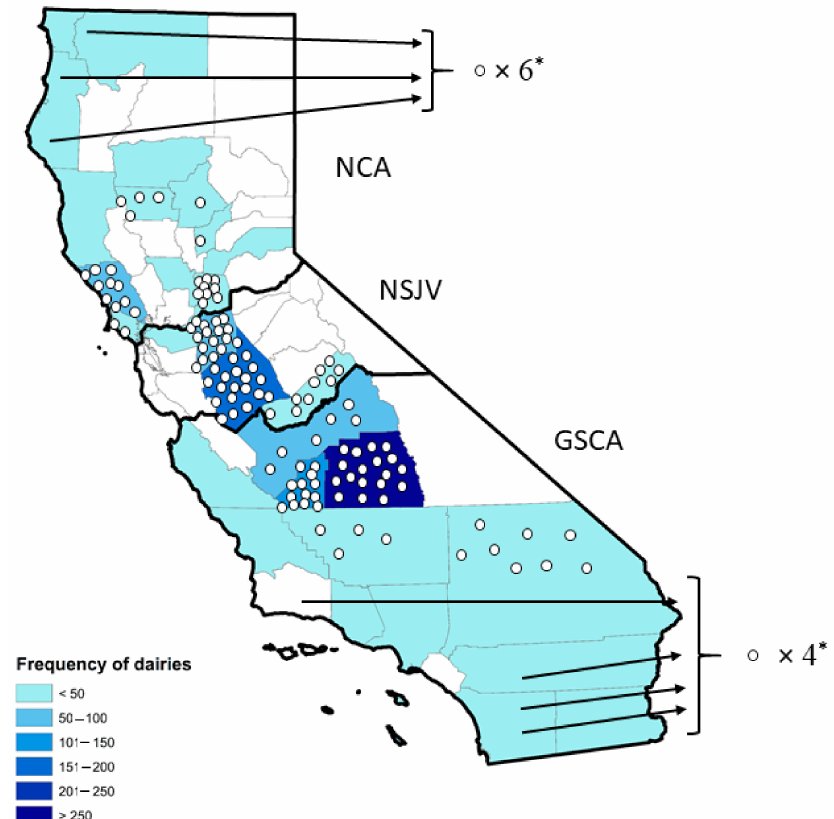
Figure 1. Map of counties in Northern California (NCA), Northern San Joaquin Valley (NSJV), and Greater Southern California (GSCA) regions used for comparison of survey responses. White dots represent the received surveys from each county. * The locations of respondents by county are censored to maintain confidentiality. Survey responses identified in the center of the county and do not reflect actual respondent